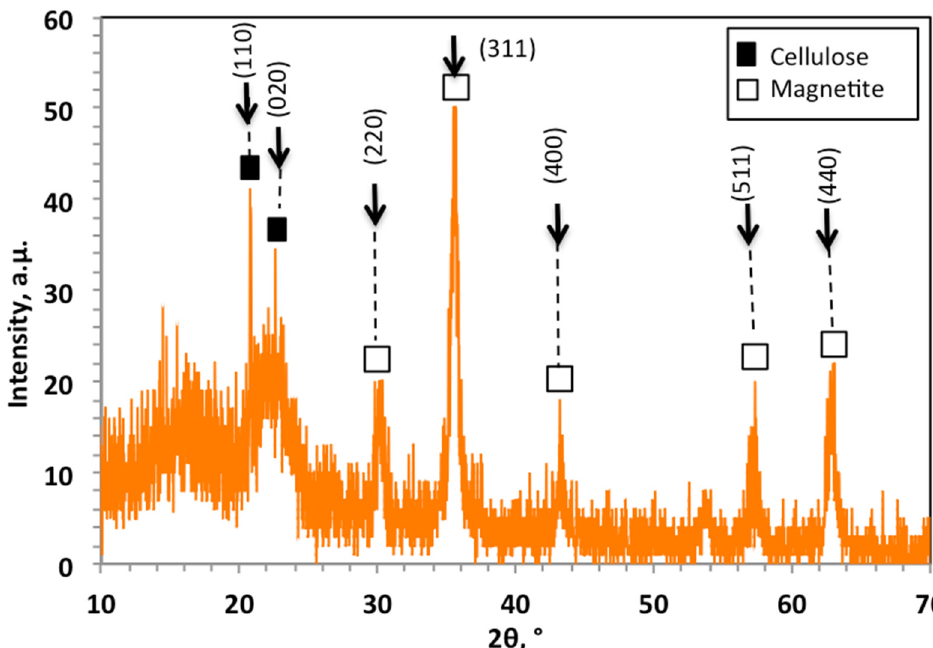
Figure 2. XRD patterns of WSD:Mag photocatalyst composite.